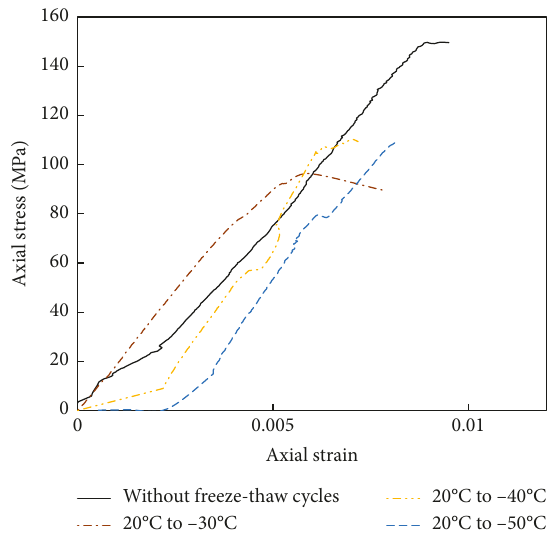
Figure 8: Stress-strain curves for tonalite specimens with and without exposure to freeze-thaw